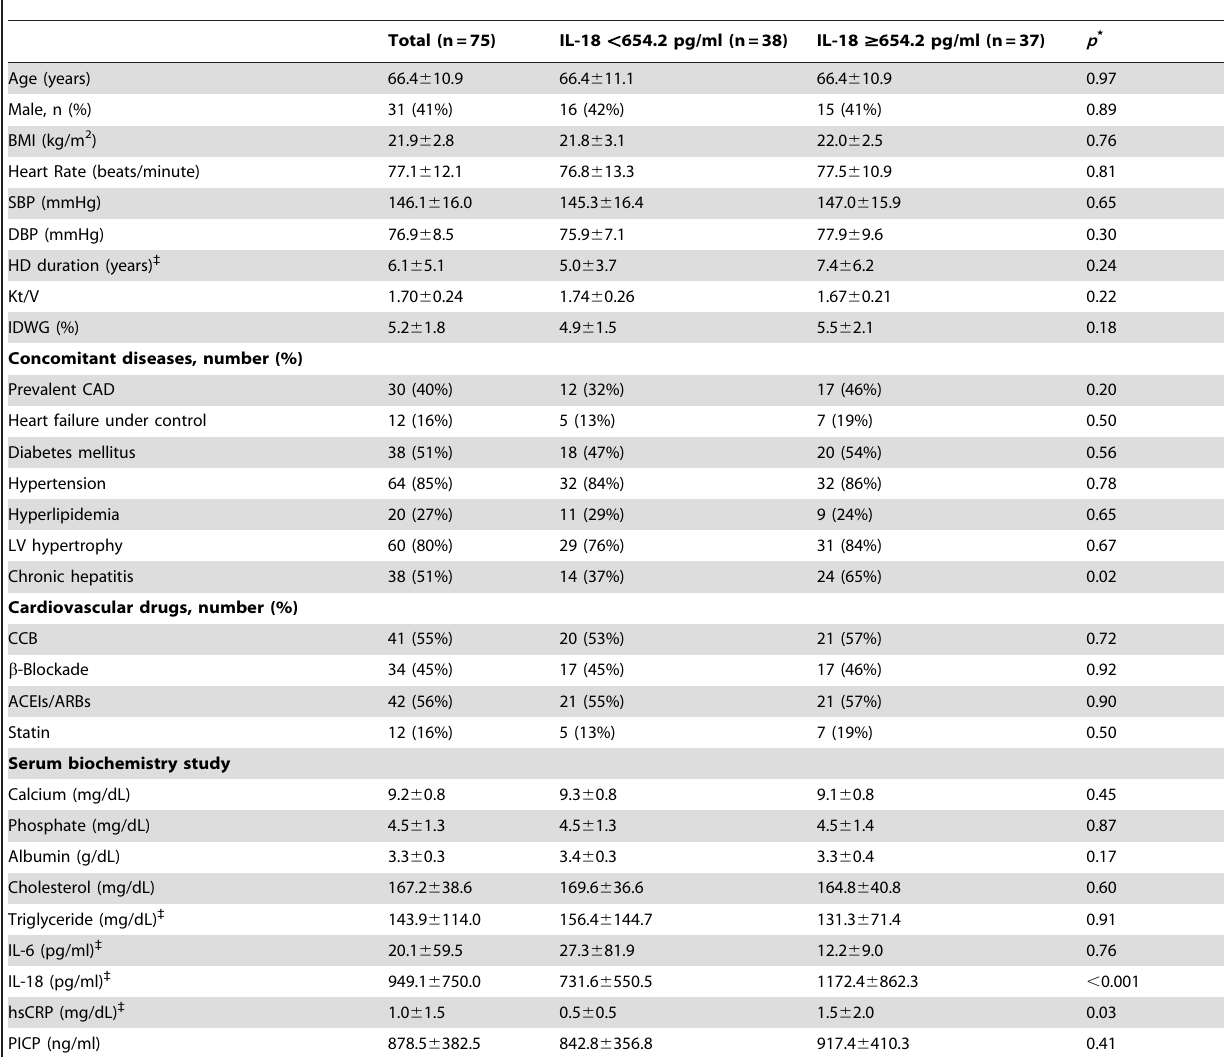
Table 1. Baseline demographic characteristic of hemodialysis (HD)